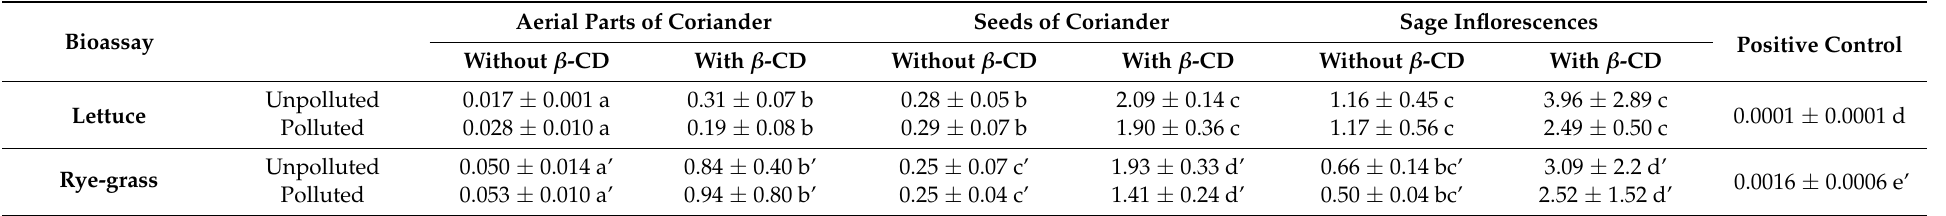
Table 3. EO’s IC 50 (g L − 1 ) resulting from the growth inhibition bioassay against lettuce and rye-grass. Values are means ± SD (n =